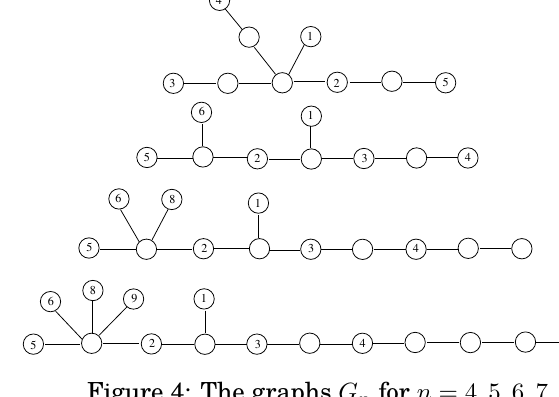
for n = 4 , 5 , 6 , 7 n